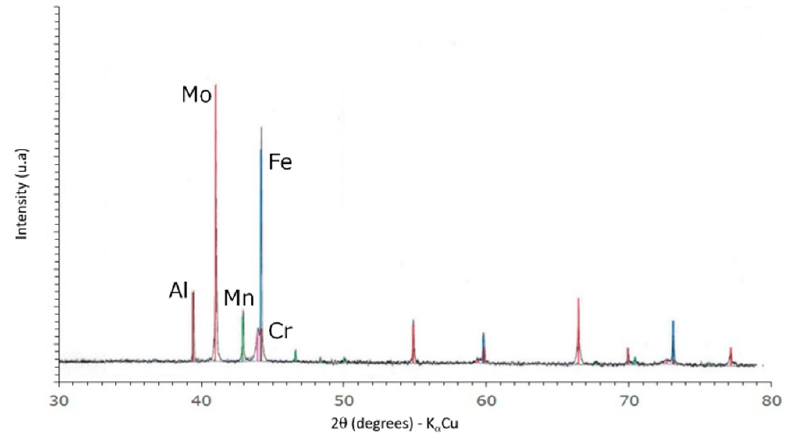
Figure 2. X-ray diffraction pattern of the initial powders FeCrAlMnMo after mixing, evidencing the presence of elemental components.